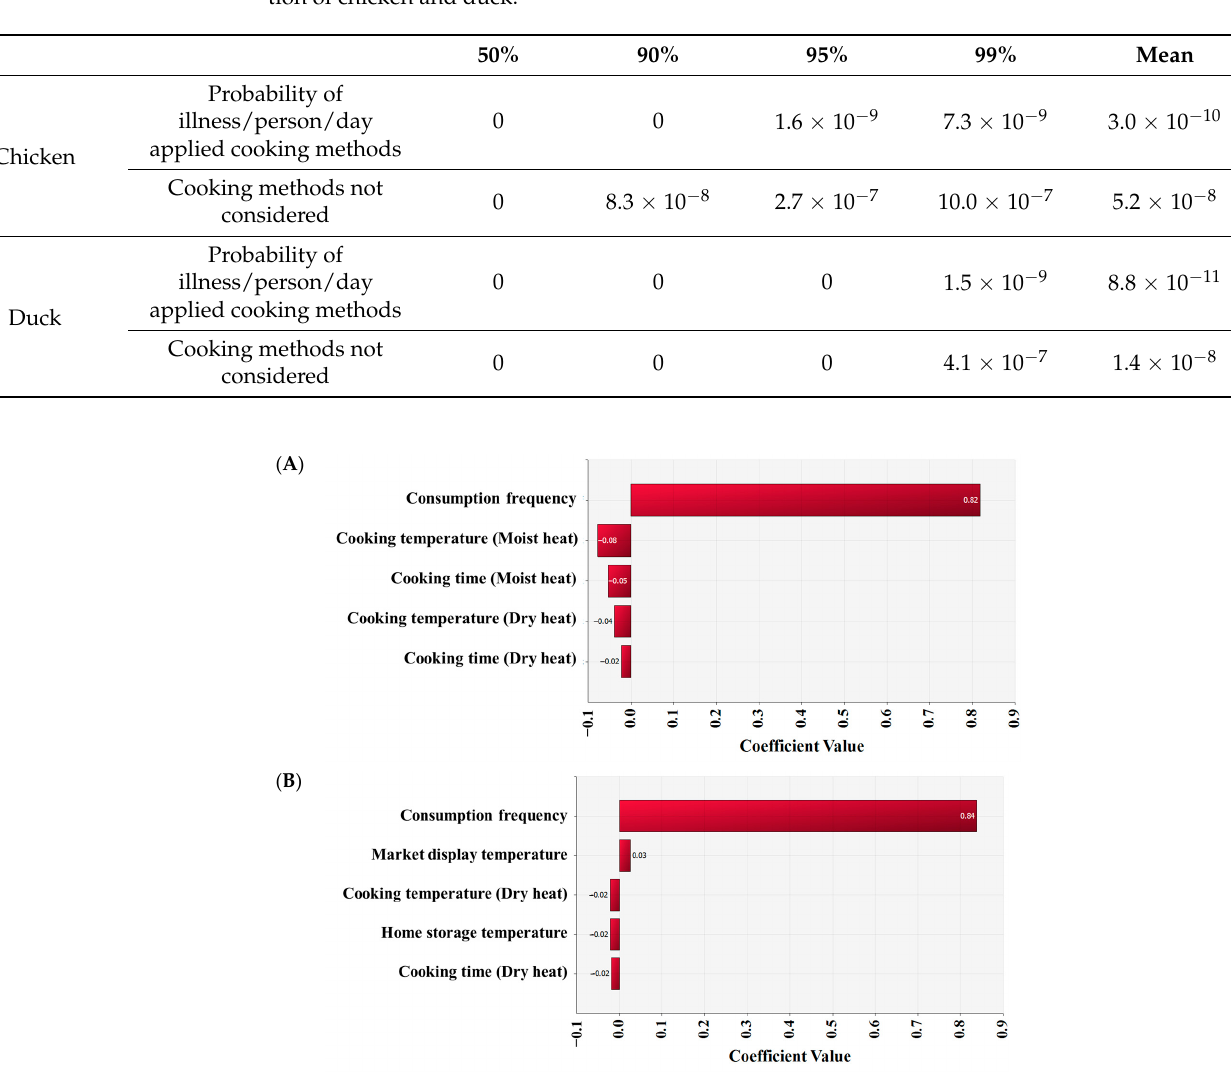
Figure 5. Coefficients of correlation for risk factors that influence the probability of Salmonella disease per person per day by poultry consumption. ( A ) Chicken, ( B ) Duck.